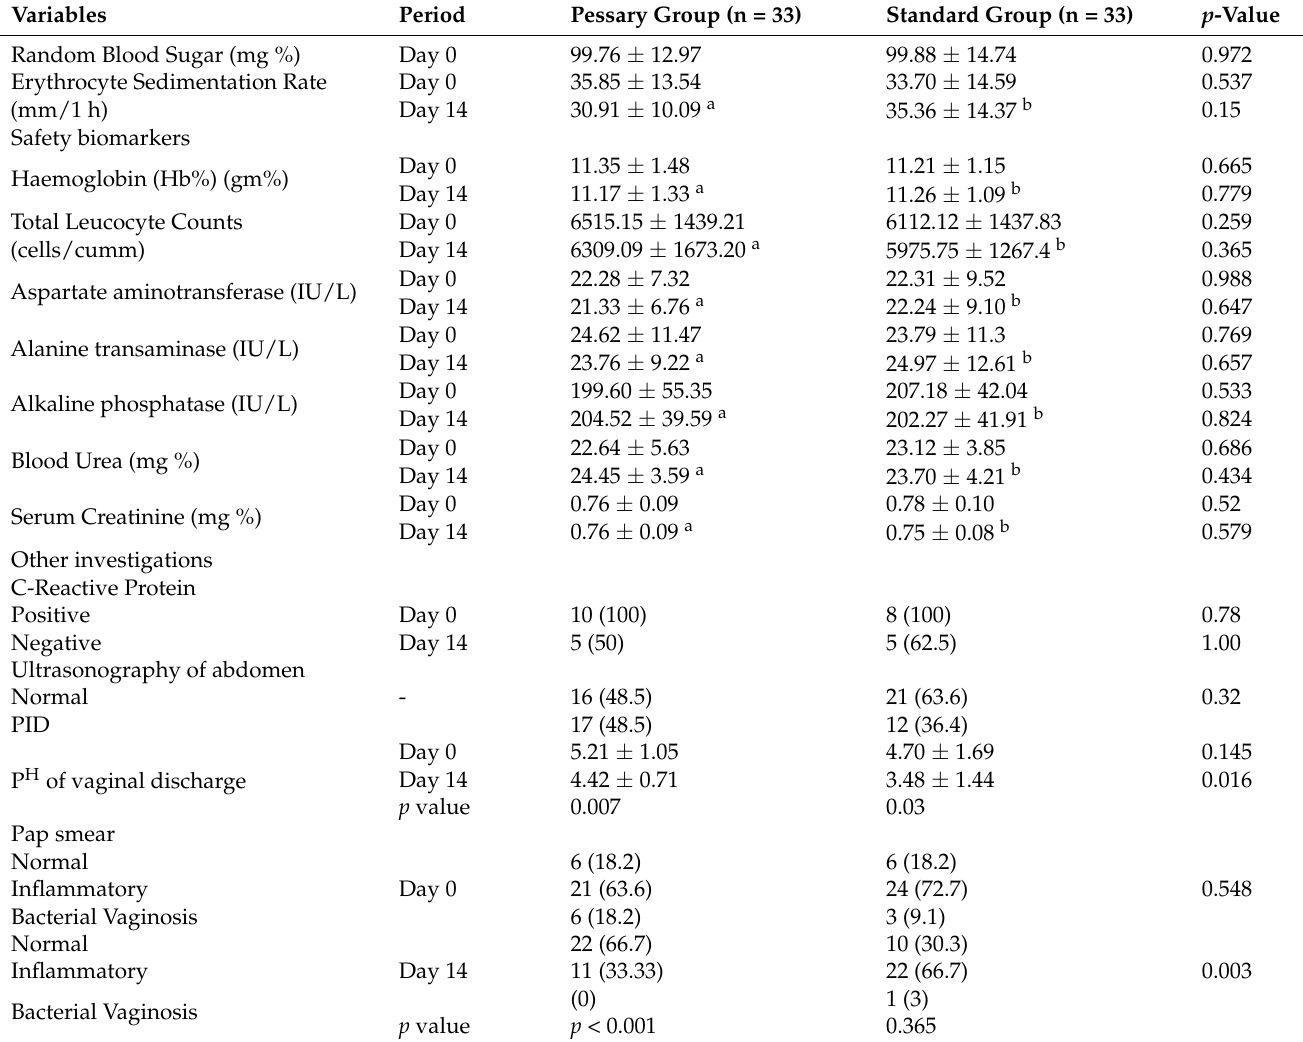
Table 7. Haematological and biochemical markers in the pessary and standard